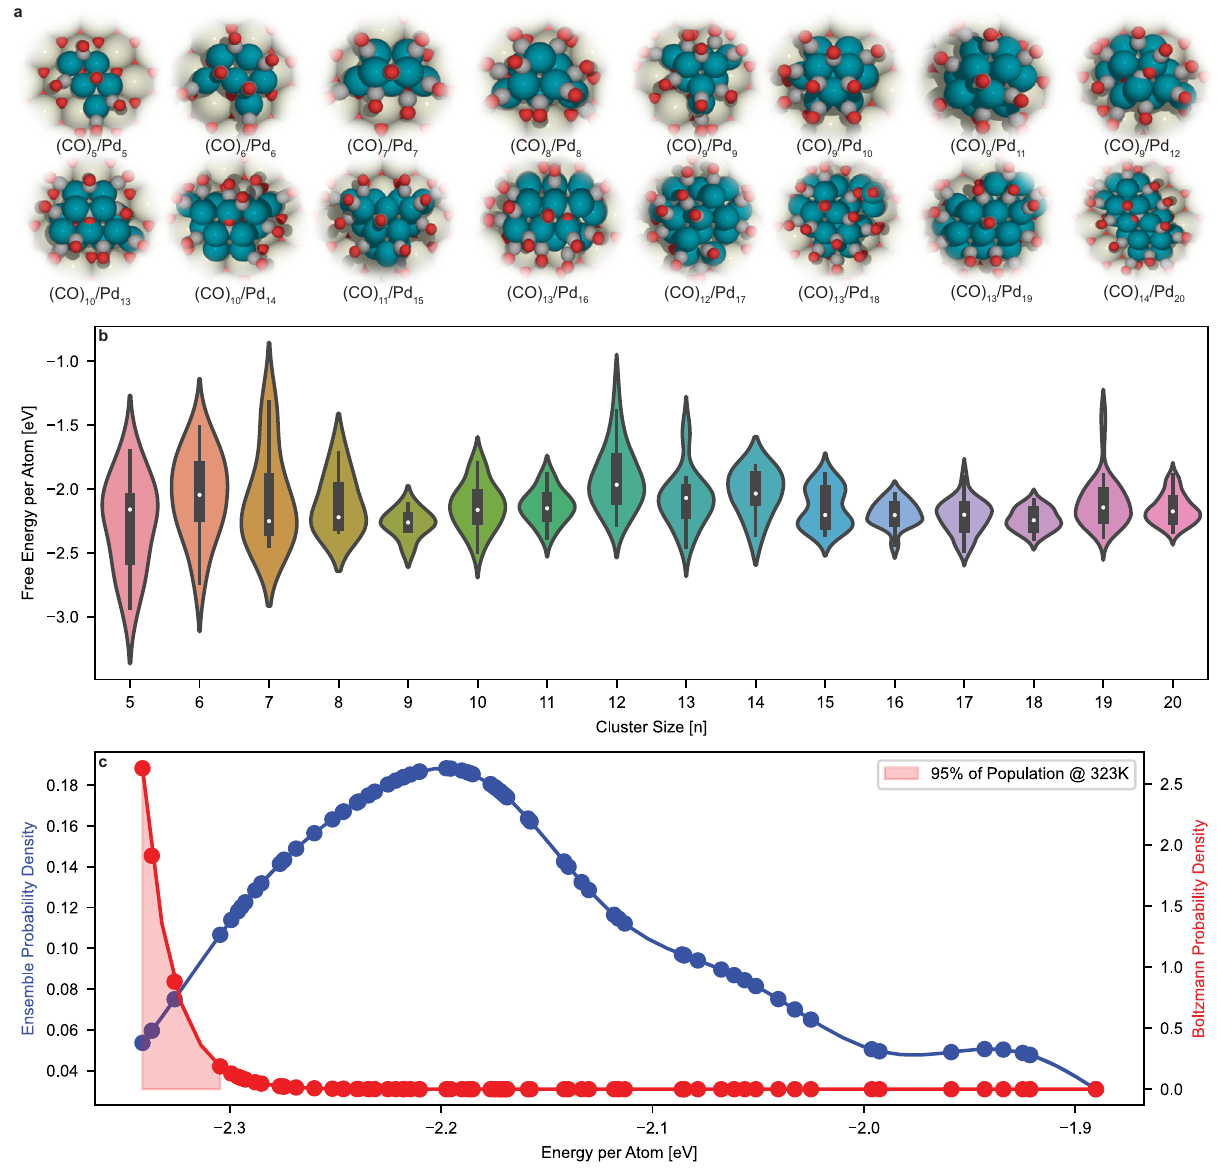
Fig.2|LowenergystructuresversusPd n /CeO 2 clustersizefor n =5 – 20at323K andsaturatedCO.a MostenergeticallystableadsorbedstructuresforagivenPd n / CeO 2 . b DistributionofGibbsfreeenergiesnormalizedbythenumberofPdatoms. c Ensemble probability and Boltzmann probability densities of Pd 20 /CeO 2 isomers saturated withCO at323Kvs. thenormalizedGibbsfreeenergy of acon fi guration. Each point along the probability density curves represents a discrete (CO) m /Pd 20 / CeO 2 con fi guration. The ensemble probability density assumes each discrete state